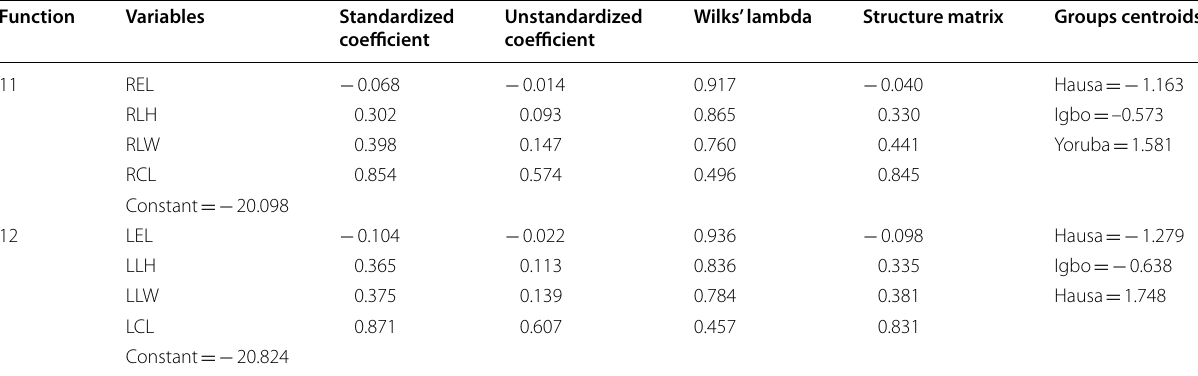
R, right; L, left; EL, ear length; EW, ear width; LH, lobule height; LW, lobule width, CL, concha length